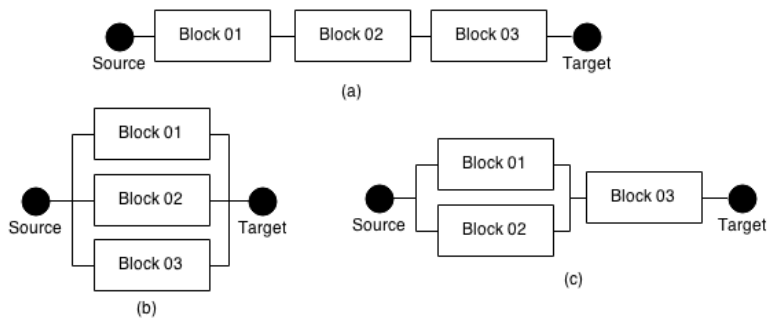
Figure 2. RBD organized in ( a ) series, ( b ) parallel and ( c )